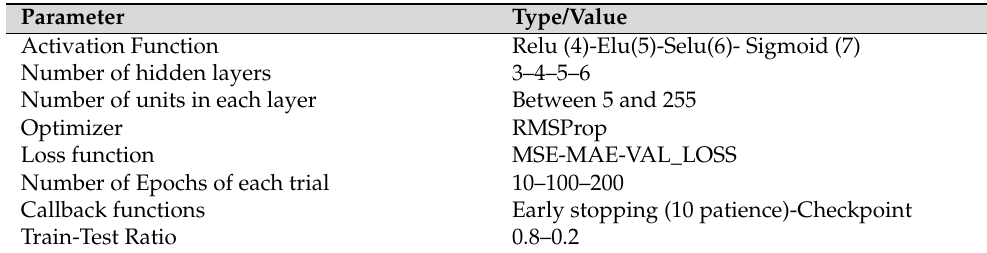
Table 4. Taguchi table of parameters assigned to their possible values (Input parameters for the non-optimized ANN) .